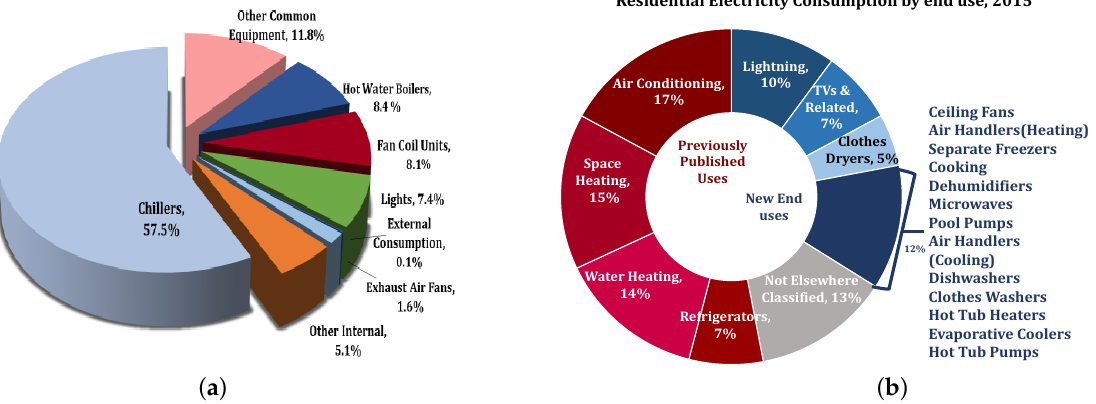
Figure 1. End-User Breakdown in Buildings retrieved From [13]. ( a ) In Warm Countries; ( b ) In Cold